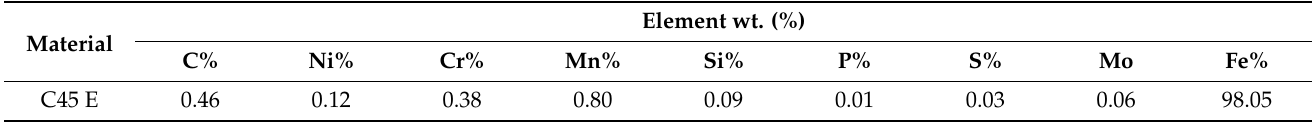
Table 1. Chemical composition of the steel * (C45E|EN 10083-2). Element wt.